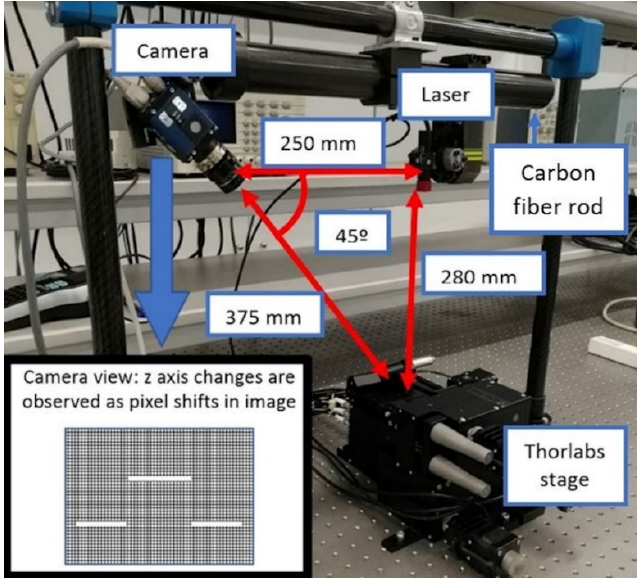
Figure 6. Main layout for experiments, including a camera and laser with a carbon fiber rod, along with the Thorlabs stage. At the bottom of the image, a block measurement is displayed in the camera.